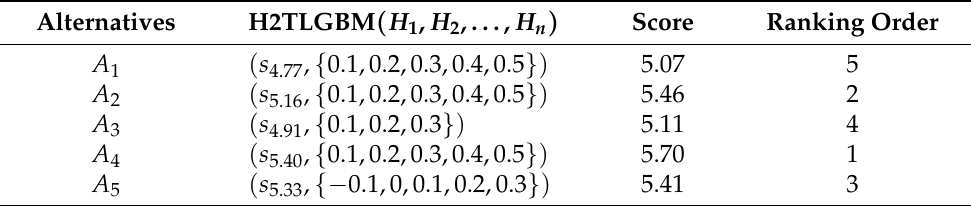
Table 7. Ranking of alternatives by using H2TLGBM operator when p = q = 1.